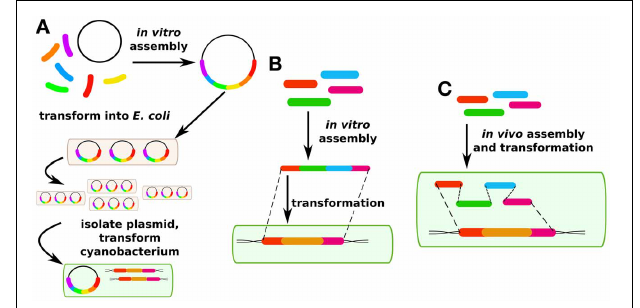
FIGURE 2 | DNA assembly methods. (A) Traditionally in cyanobacterial synthetic biology, plasmids are assembled in vitro and then propagated in E. coli before being transformed into cyanobacteria. (B) More recently, methods have been developed for in vitro assembly and direct transformation via fusion PCR. (C) Another recent method has been developed for in vivo plasmid assembly via homologous recombination in yeast which may also be applicable in certain cyanobacterial